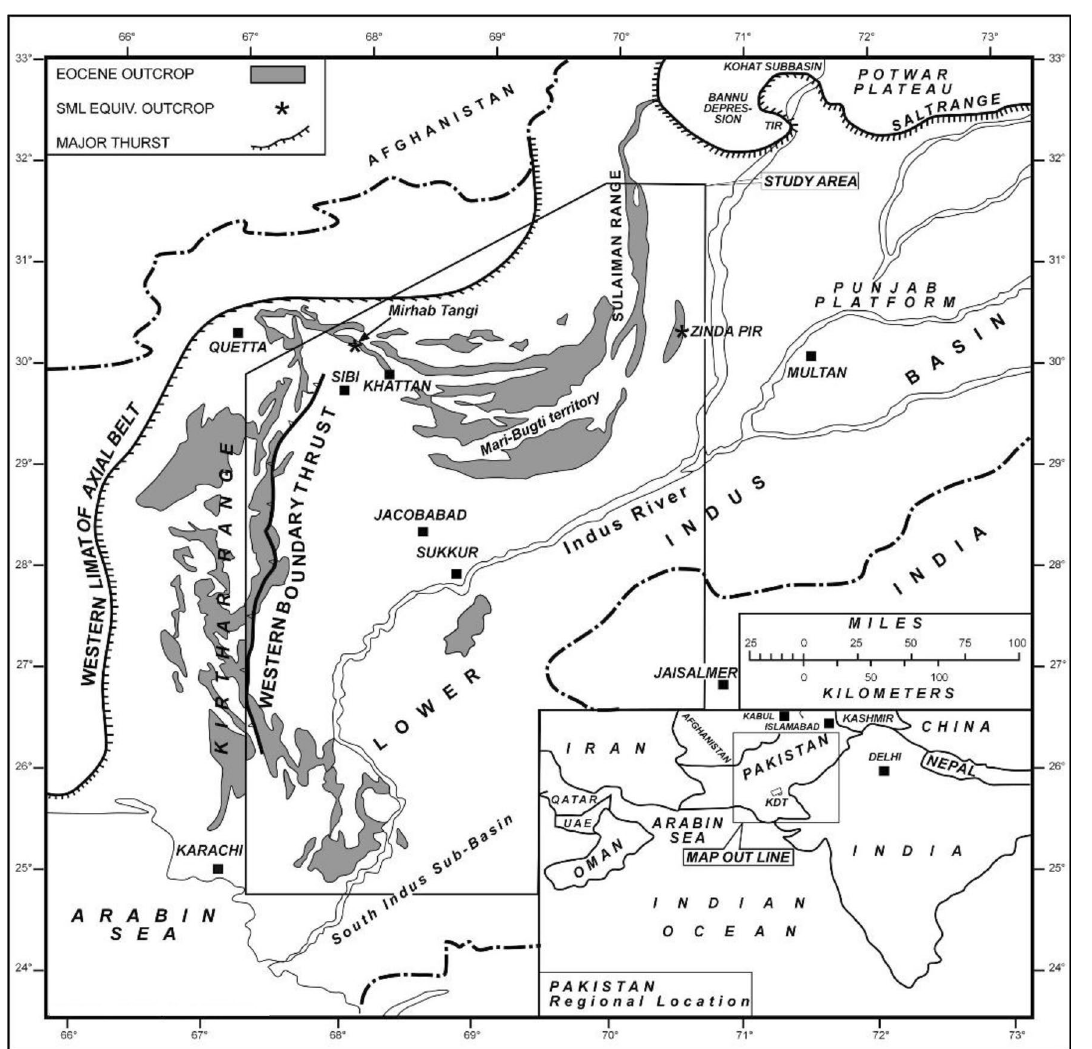
Fig. 1 Location map of the study area lying in Middle Indus Basin of